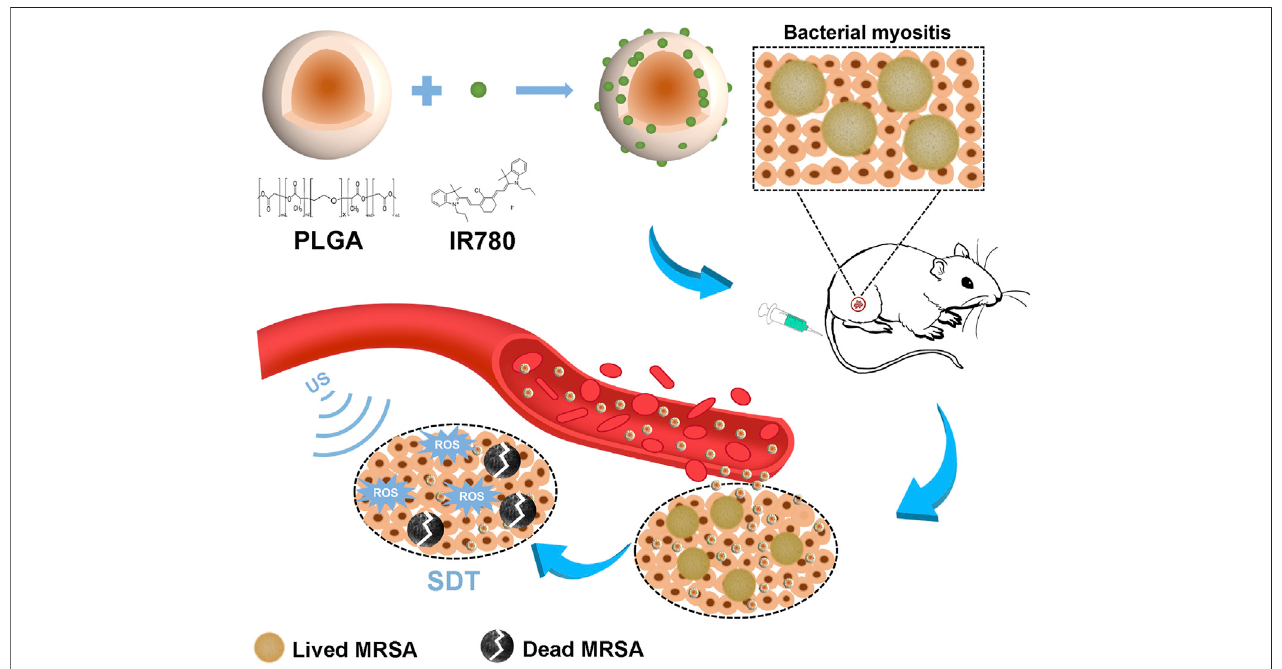
FIGURE 1 | Schematic illustration of the sonotherapeutic IR780@PLGA nanoparticles for combating multidrug-resistant bacterial